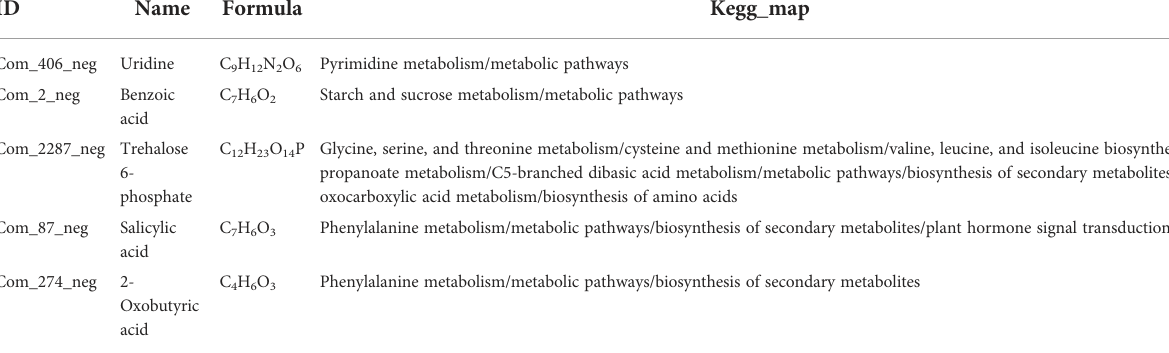
TABLE 2 Five candidate metabolites in negative ion mode for salt-tolerant (ST) sorghum genotype under salt treatments